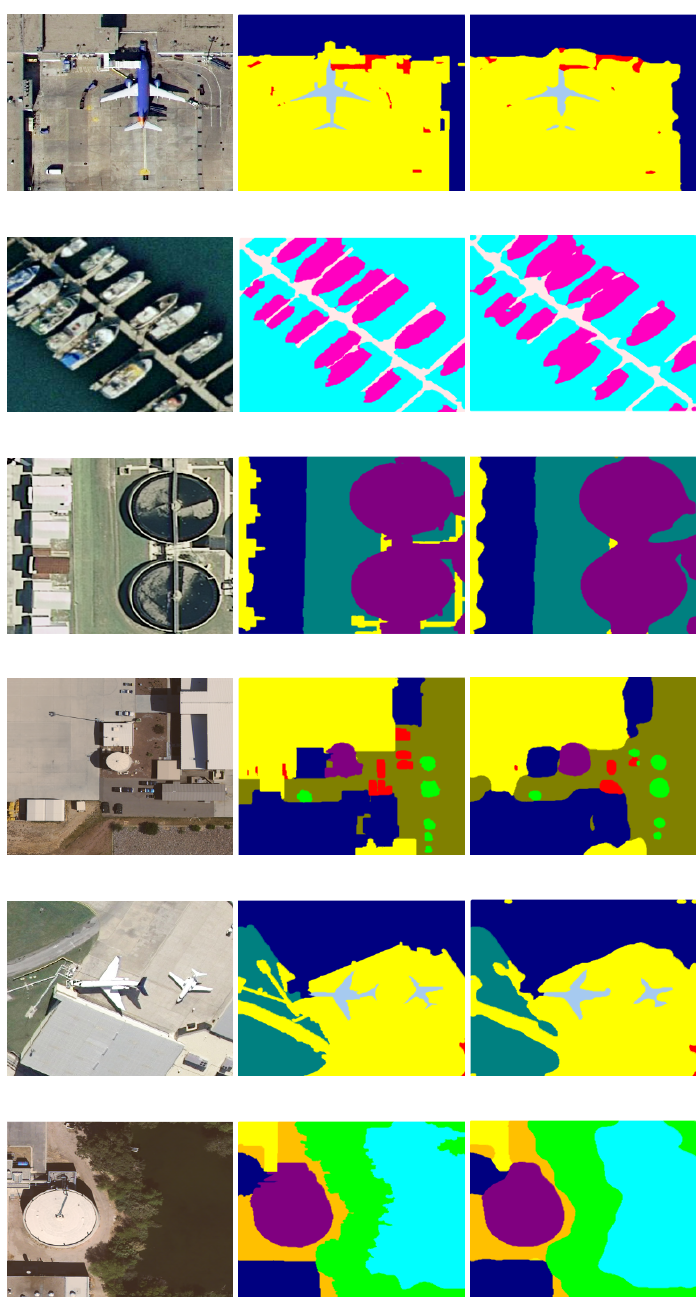
Figure 3. Visualization of the land cover semantic segmentation by the proposed method. The first column shows samples’ frames from the dataset. Second column is the ground truth masks and third column is the predicted segmentation